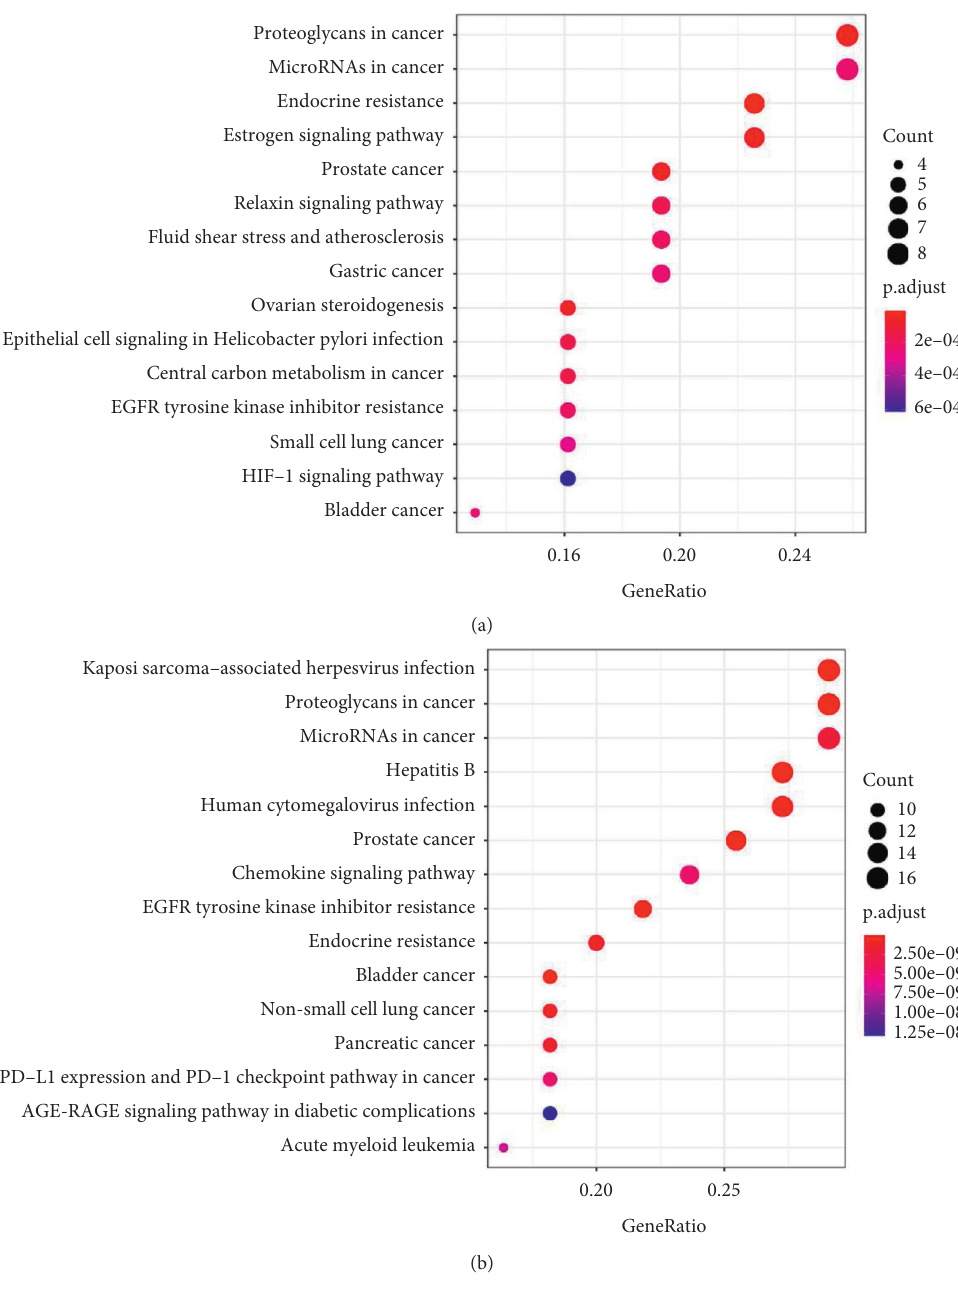
Figure 4: KEGG bubble. The horizontal axis of the KEGG bubble diagram represents the gene proportion enriched in each entry, and the vertical axis shows the enrichment degree according to the corrected p